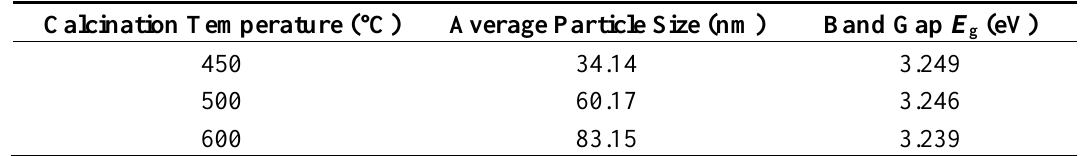
Figure 6. (F( R ∞)· hv ) 2 vs. ( hv ) plots of of ZnO nanoparticles at different calcination temperatures. Table 2. Average particle size and band gap energy of ZnO nanoparticles at different calcination